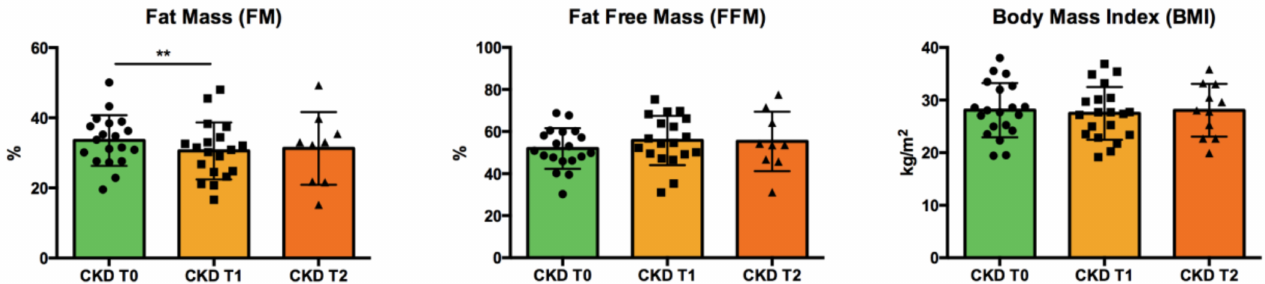
Figure 1. Effects of Meriva ® supplementation on fat mass (FM), fat-free mass (FFM), and BMI: com- parison between baseline (CKD T0), after 3 months supplementation (CKD T1), and after 6 months supplementation (CKD T2); ** p <